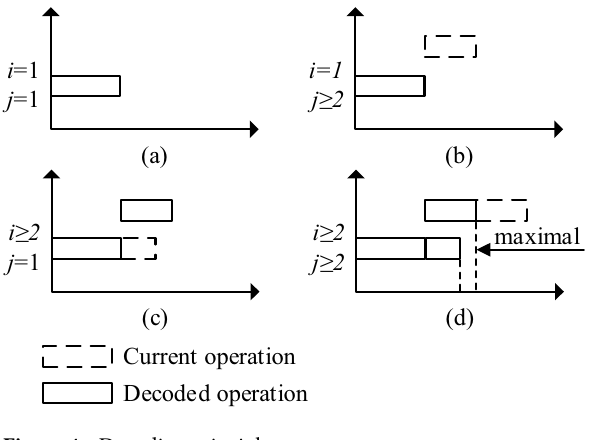
Figure 4. Decoding